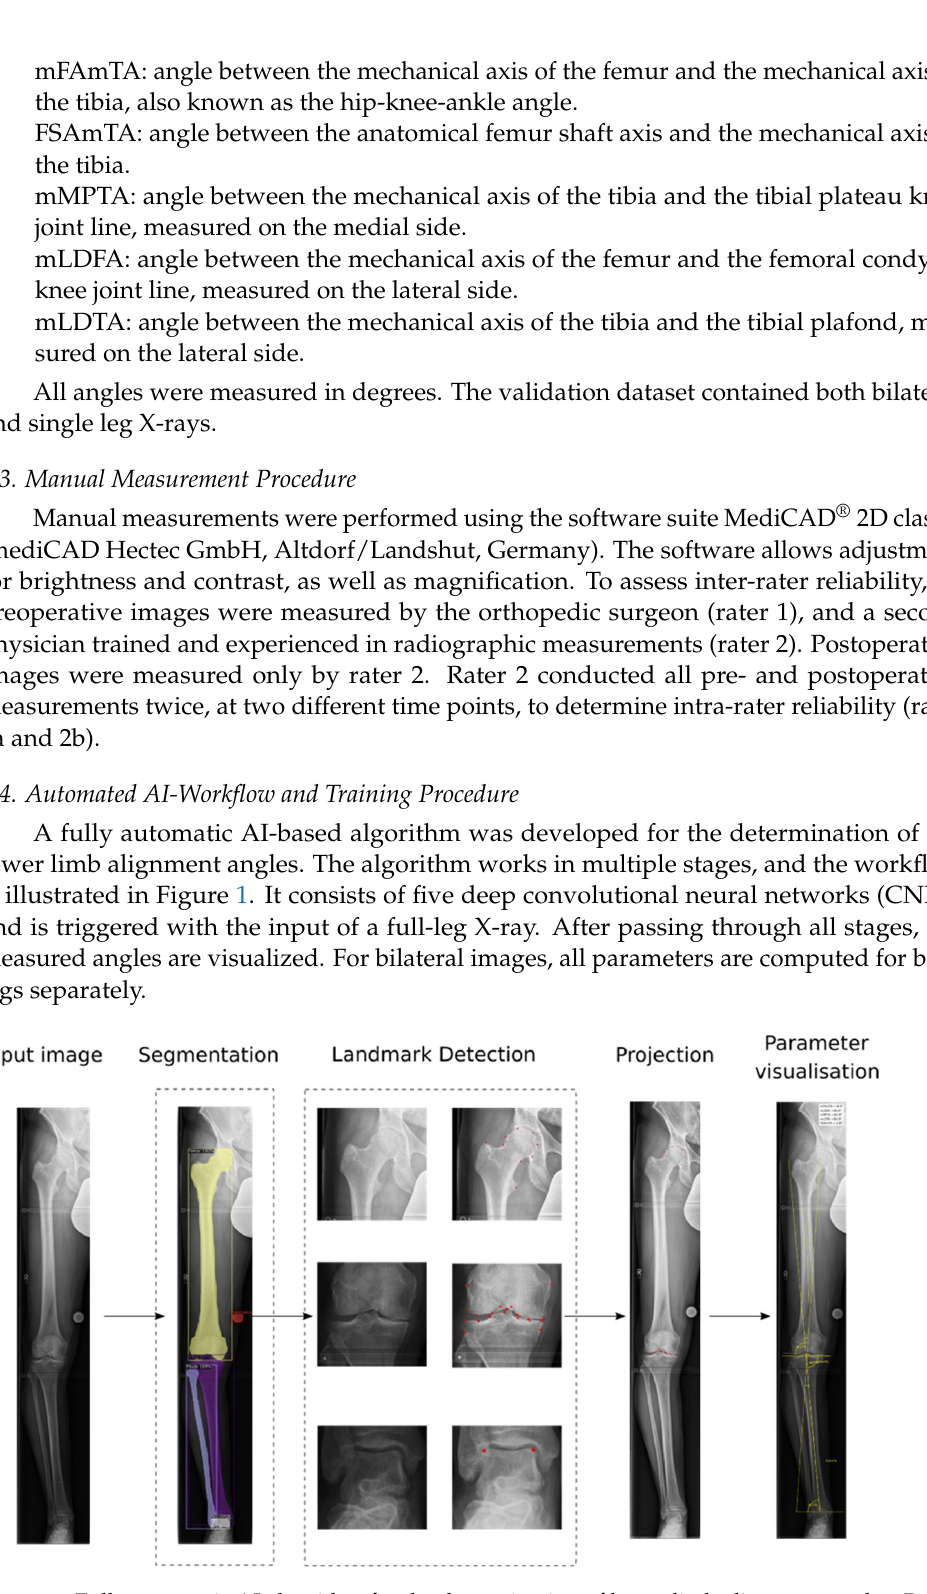
Figure 1. Fully automatic AI algorithm for the determination of lower limb alignment angles. Based on the predicted segmentation masks around anatomical structures and implants, crops of the proximal femur, knee area, and ankle joint were created. Landmark detection models predicted landmarks on these smaller crops. The landmarks were projected back on the original image, and the final parameters were computed and visualized.